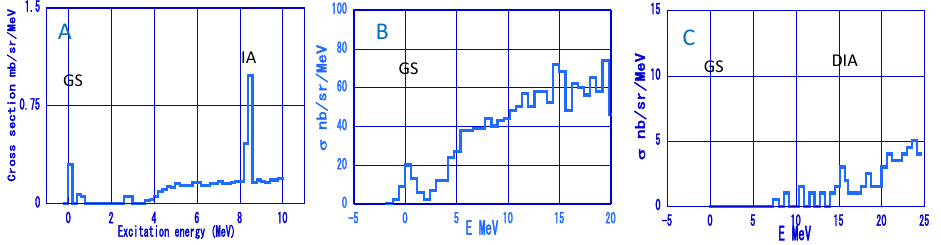
Figure 4. Energy spectra of the SCER and the DCERs. ( A ): SCER of ( 3 He, t ) on 76 Ge at θ = 2–2.5 deg., where the SD ( L = 1) excitation obtains maximum [18]. ( B ): DCER of ( 11 B, 11 Li) on 13 C at θ = 0–2.5 deg., where GTSQ ( L = 2) excitation obtains maximum [24]. ( C ): DCER of ( 11 B, 11 Li) on 56 Fe at θ = 0–2.5 deg., where GTSD ( L = 1) excitation obtains maximum [24]. GS: Ground state. IA: isobaric analogue